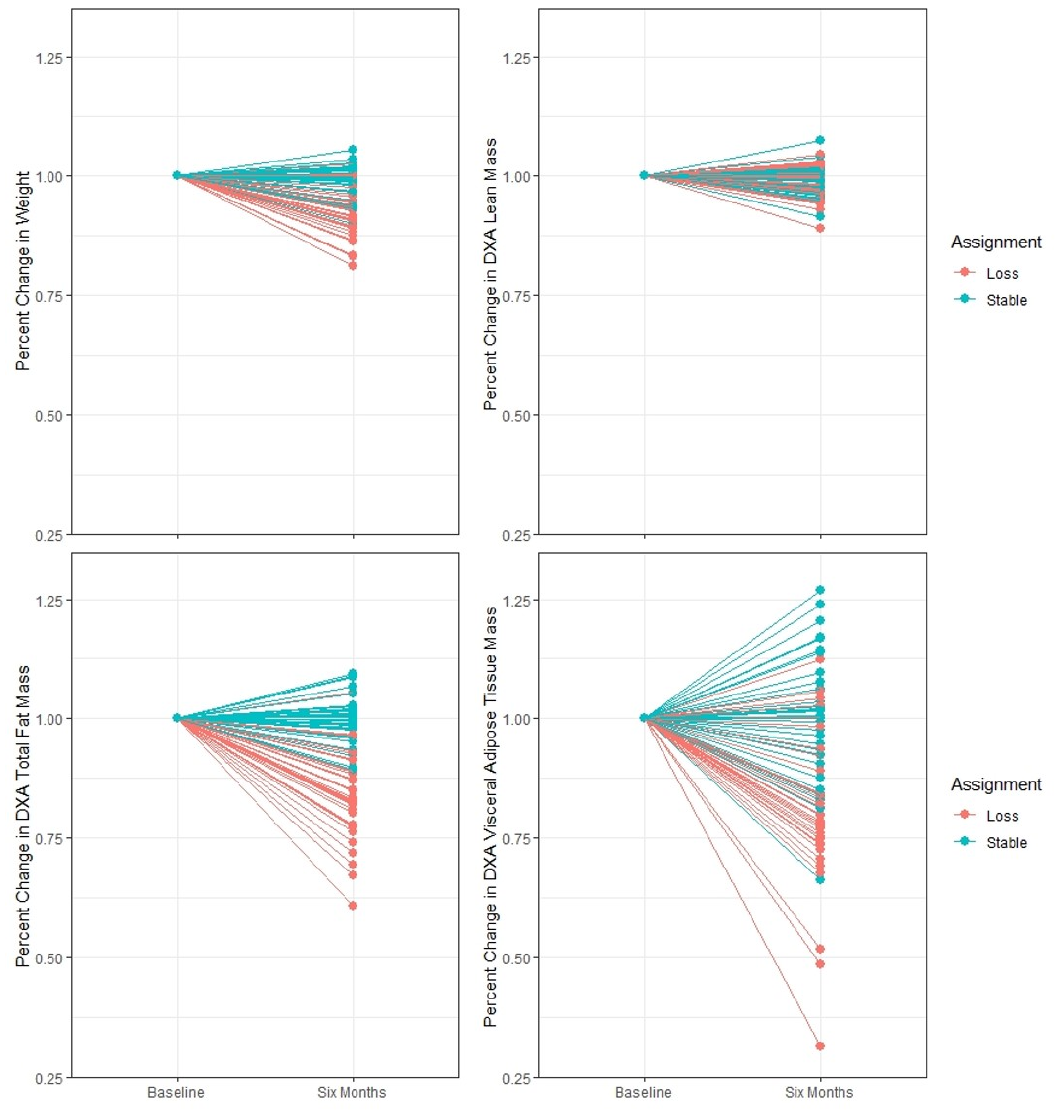
Figure 1. Change in the weight and body composition. From baseline to six months, the percent change in total body weight, lean mass, fat mass, and visceral adipose tissue (VAT) mass in individuals randomized to the weight loss (orange; n = 38) and weight stable (teal; n = 36) groups.